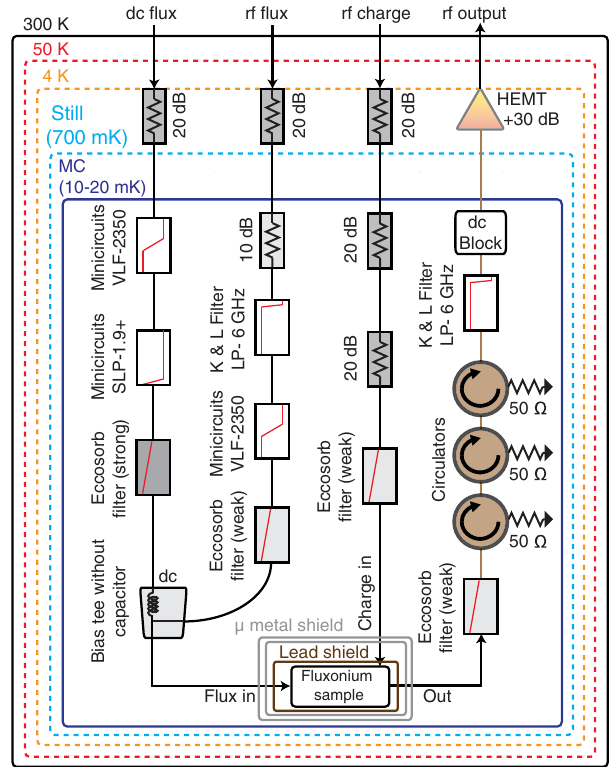
FIG. 5. Wiring diagram inside the dilution refrigerator. Outside the dilution fridge, there is approximately 16 dB of attenuation and a dc block on the rf-flux line and an ultralow-pass (approximately 1 Hz) RC filter on the dc flux line. The total attenuation on the rf-flux line proves important for both the T 1 and T 2 of the qubit, likely due to reduction in noise from the arbitrary waveform generator (Agilent